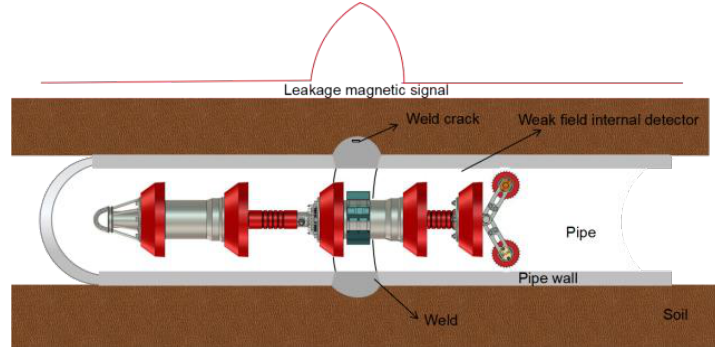
Figure 2. Schematic diagram of in-pipeline detection.